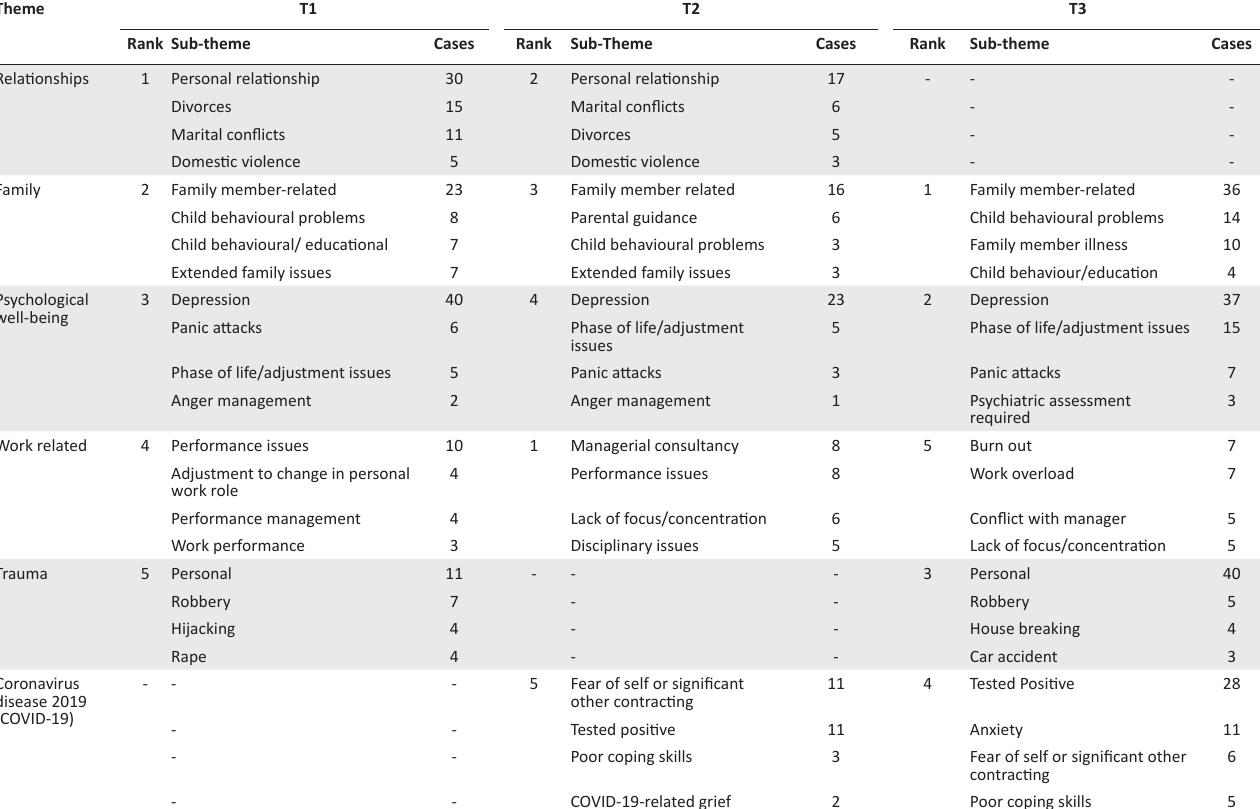
TABLE 5: Top five themes and sub-themes per period. Theme